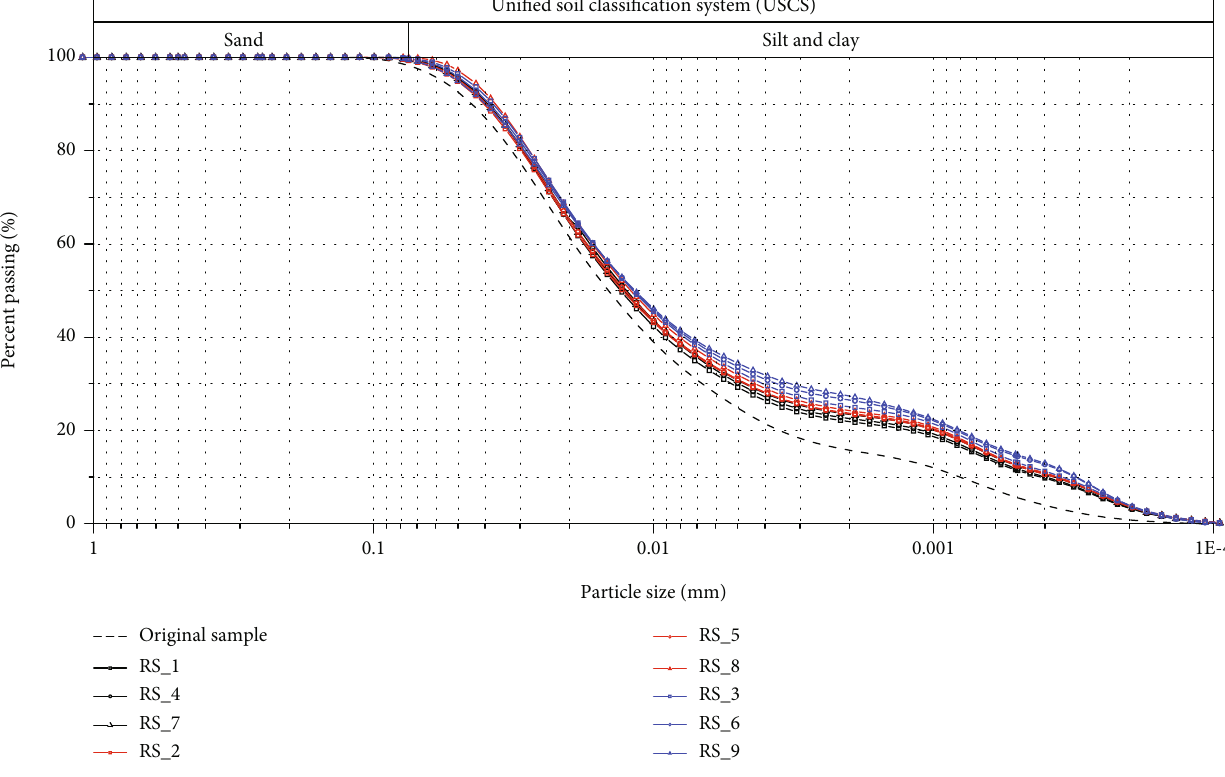
Figure 10: Particle size distributions of samples after the tests. Table 4: Summary of particle size distribution